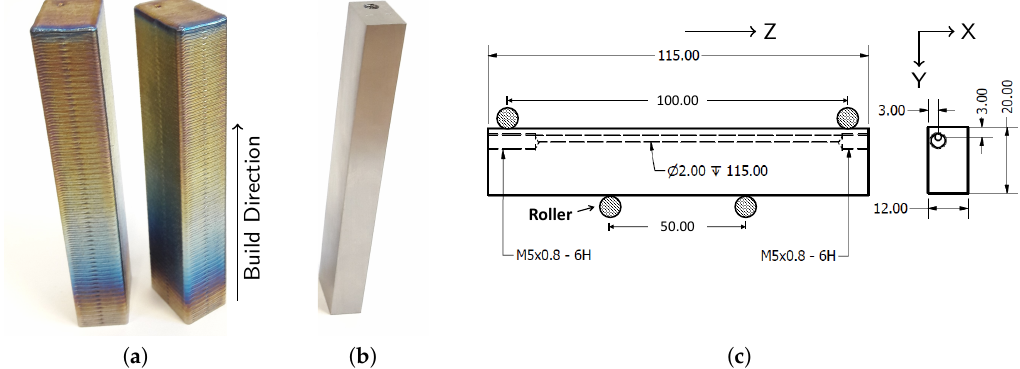
Figure 1. Additive manufactured Ti-6Al-4V specimen produced by laser based DED in as-built condition ( a ) before milling and ( b ) after milling according to the design presented in ( c